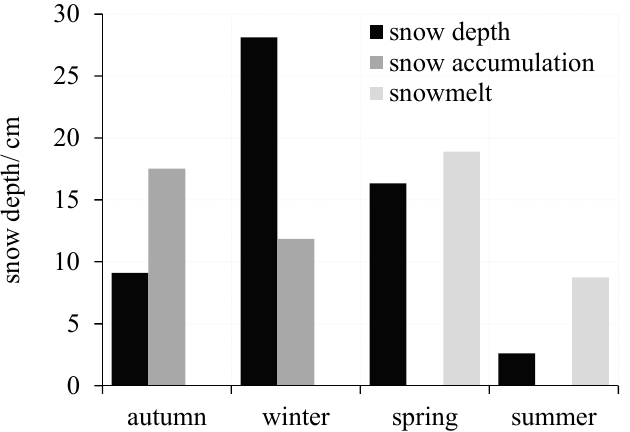
Figure 1. Annual variations in seasonal snow depth, snow accumulation and snowmelt over the TP (unit: cm).